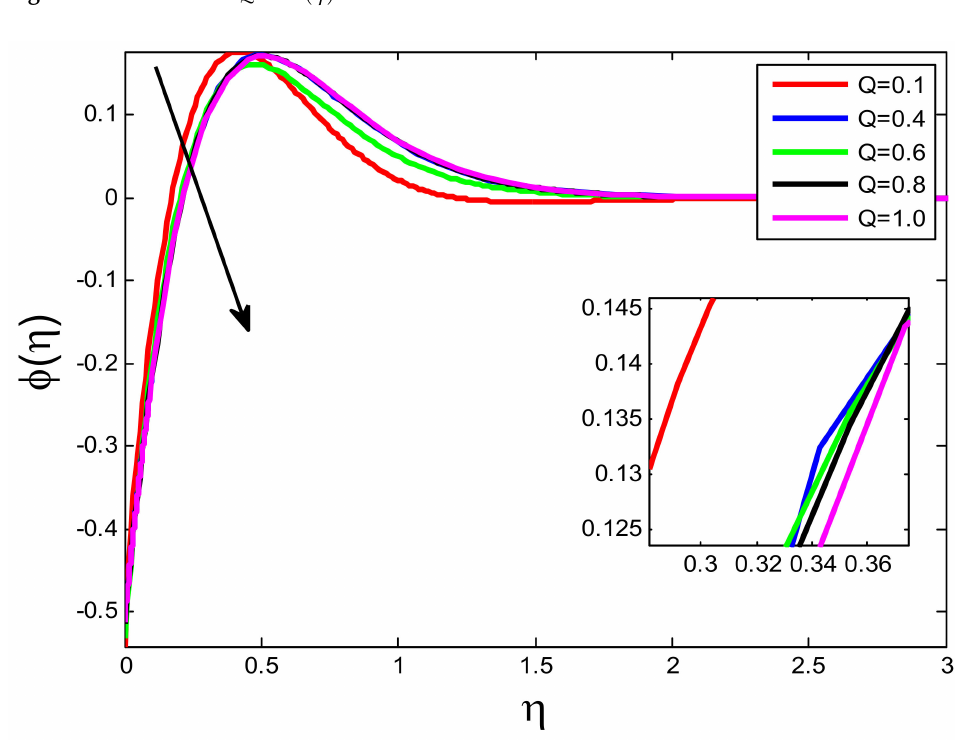
Figure 27. Influence of Q on φ ( η )